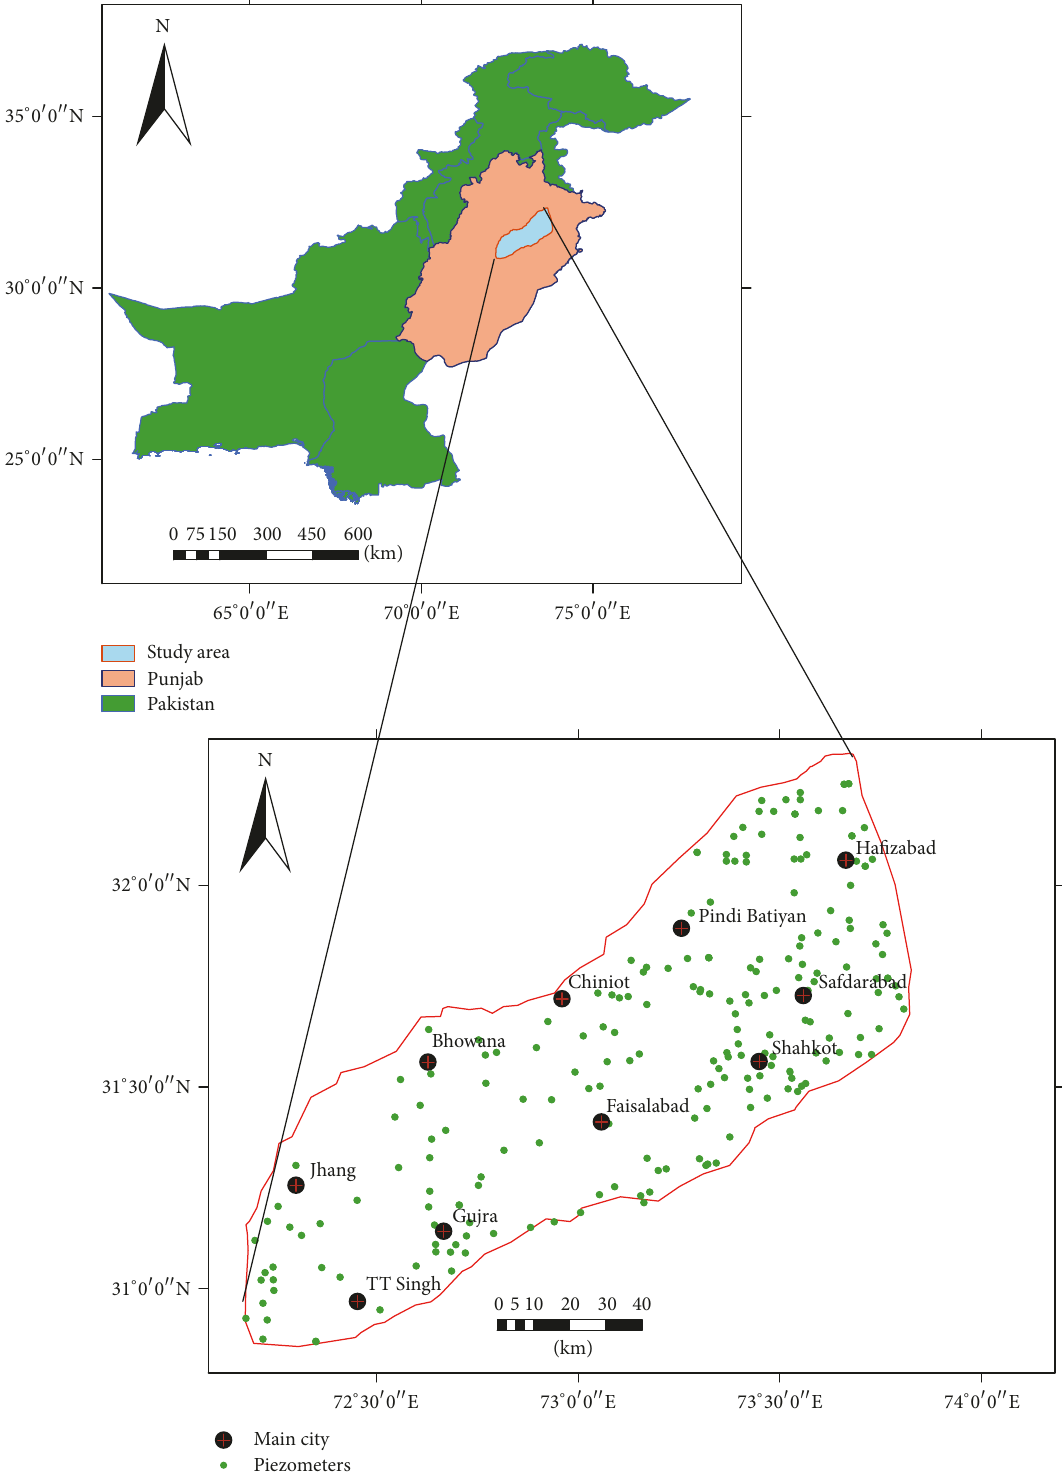
Figure 1: Geographical location of study